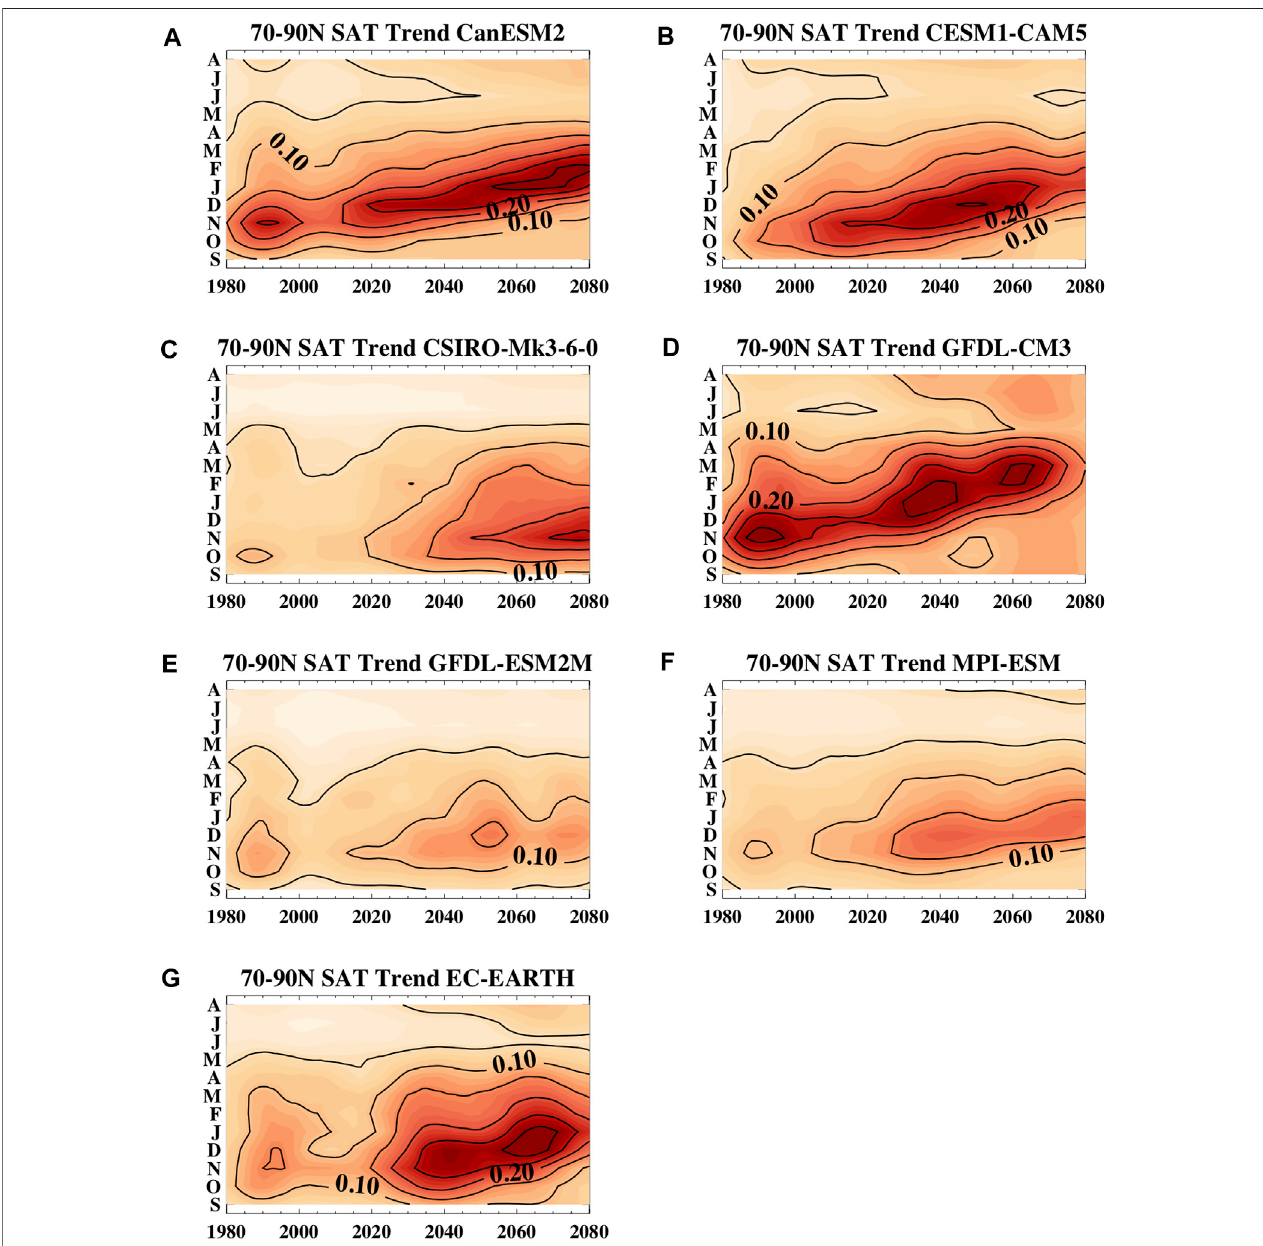
FIGURE13| Therunning20-yearstrendinthe70 – 90Nensemblemeansurfaceairtemperatureasafunctionofmonthoverthe21stcenturyinthedifferentSMILES including (A) CanESM2, (B) CESM1-CAM5, (C) CSIRO-Mk-3-6-0, (D) GFDL-CM3, (E) GFDL-ESM2M, (F) MPI-ESM, and (G) EC-EARTH. The lined contour interval is 0.05 ° C per year. Note that the y -axis runs from September on bottom through August on top to better highlight the changing seasonality of warming in the models.